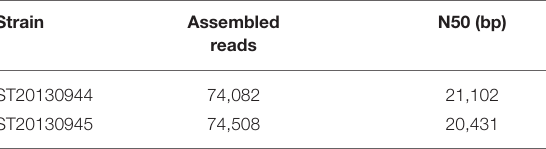
TABLE 1 | SMRT mapping statistical summary